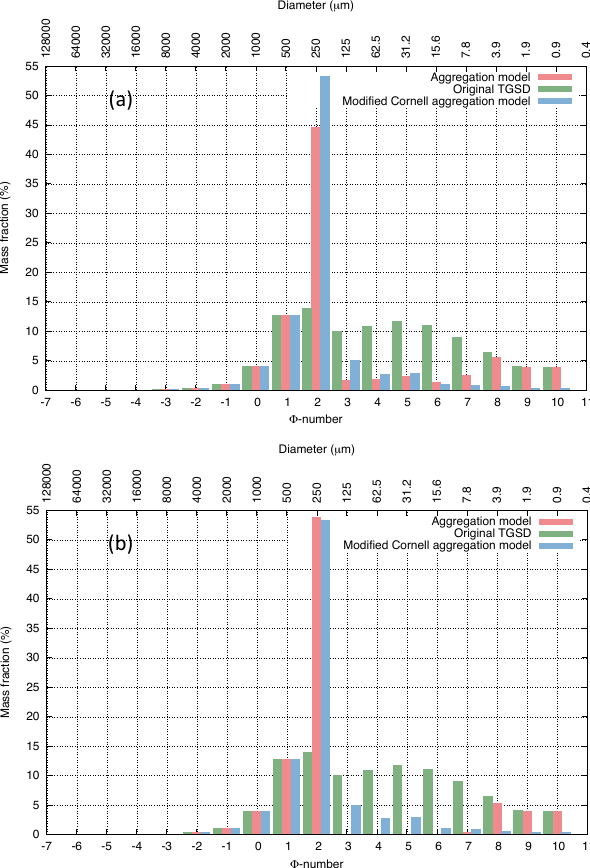
Figure 7. Results of the aggregation model in FPLUME for El Chichón 1982 phase-B simulation. Green bars show the original TGSD from Rose and Durant (2009) discretized in 17 (cid:56) -classes. Blue bars show the results of the modified Cornell model. Finally, read bars give the results of our wet aggregation model considering a fractal exponent of D fo = 2 . 92 (a) and D fo = 2 . 96 (b)